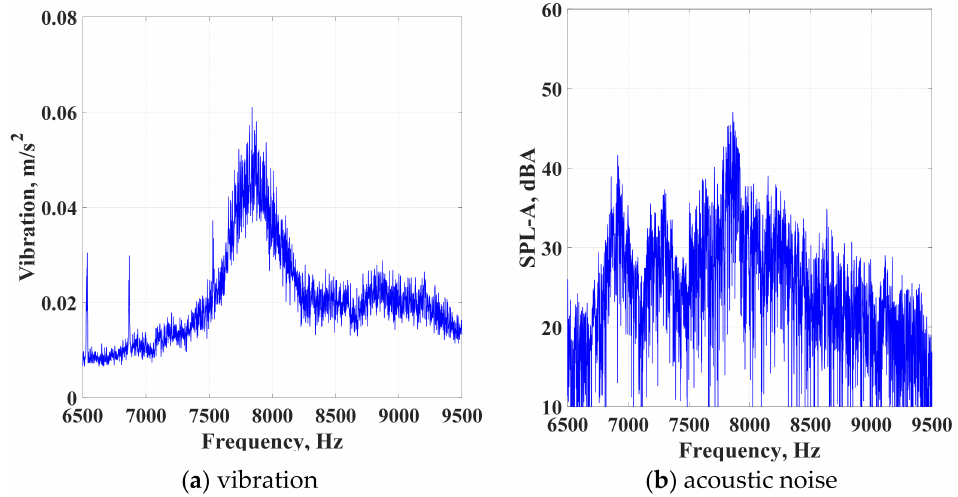
Figure 11. The sideband vibro-acoustic responses with random PWM.